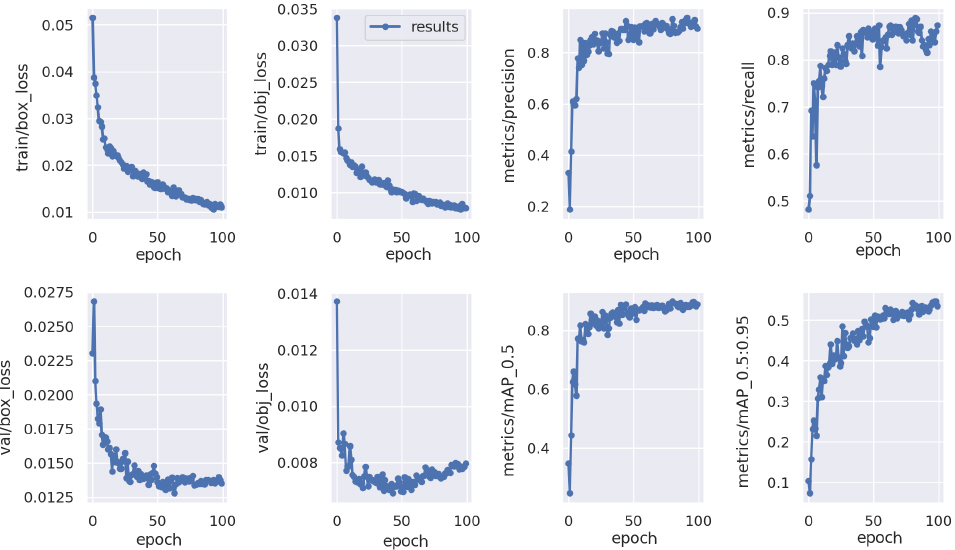
Figure 7. The progress in the performance of the proposed fine-tuned model during the training